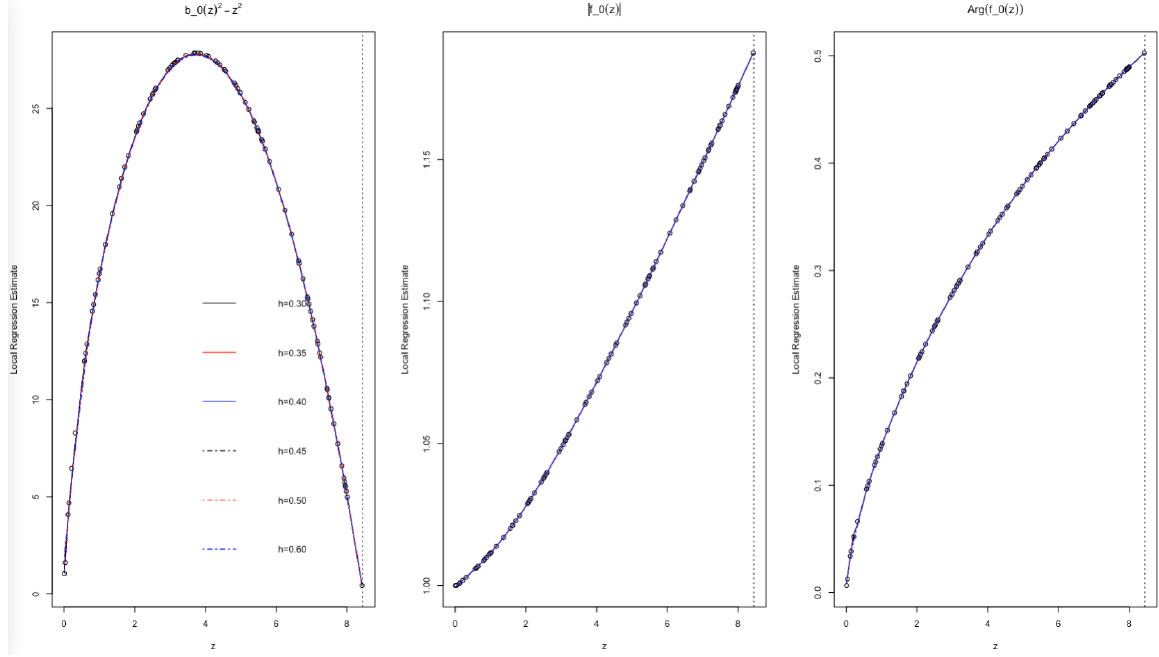
Figure 12. The estimates of critical collapse functions corresponding to a γ solution of ahy- perbolic case based on a local regression method of order l = 1 with bandwidth parameters h = { 0.30,0.35,0.40,0.45,0.50,0.60 } based on a training sample of size n = 100. The local regression estimators outperform the kernel and polynomial counterparts in estimation in almost all three critical collapse functions in both elliptic and hyperbolic